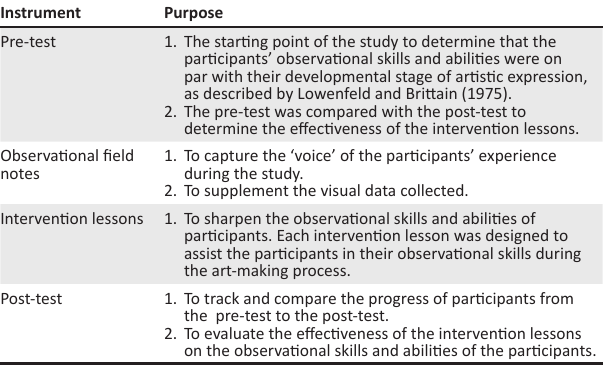
TABLE 1: Data collection tools and